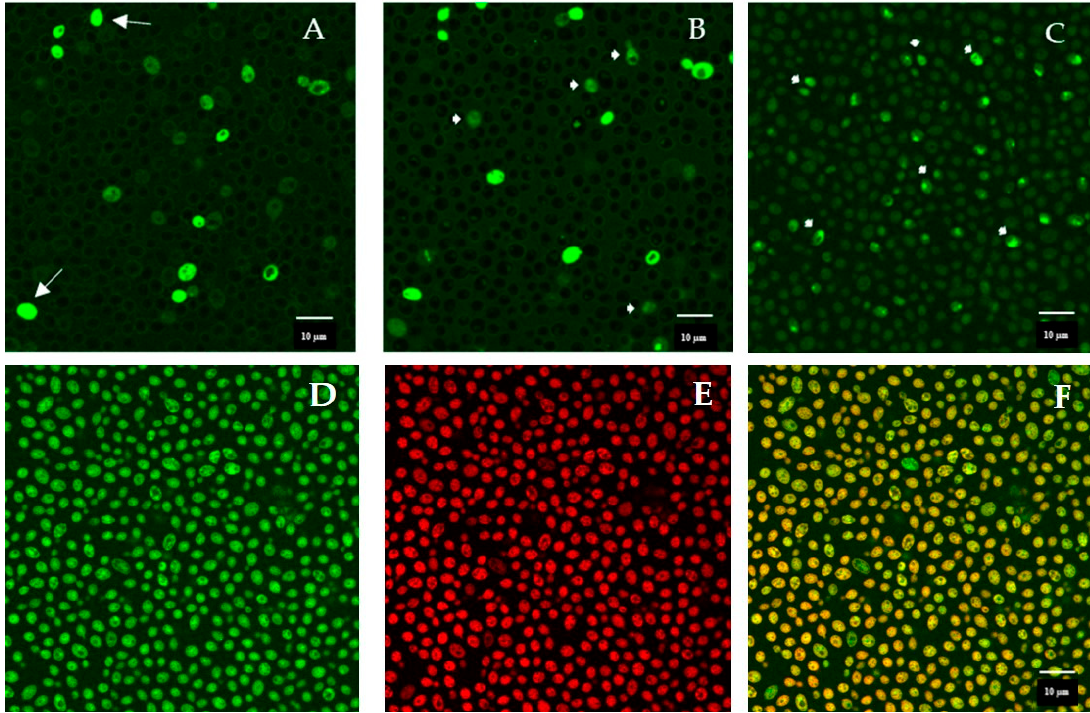
Figure 7. Confocal microscopy images of Candida albicans cells treated with fluorescein isothiocyanate (FITC)-labeled K13L for 5 min (panel A ), 75 min (panel B ), 285 min (panel C ), and 315 min, 30 min after addition of propidium iodide (PI) (panel D , FITC, panel E , PI, panel F , merge). Some non-viable yeast cells are already present in the inoculum (panel A , arrows); over time, intracellular localization of FITC-labeled K13L is observed (some cells indicated by arrowheads, panels B and C ). Peptide internalization led to cell death, as demonstrated by the merge of green (FITC) and red (PI) signals in panel F ).